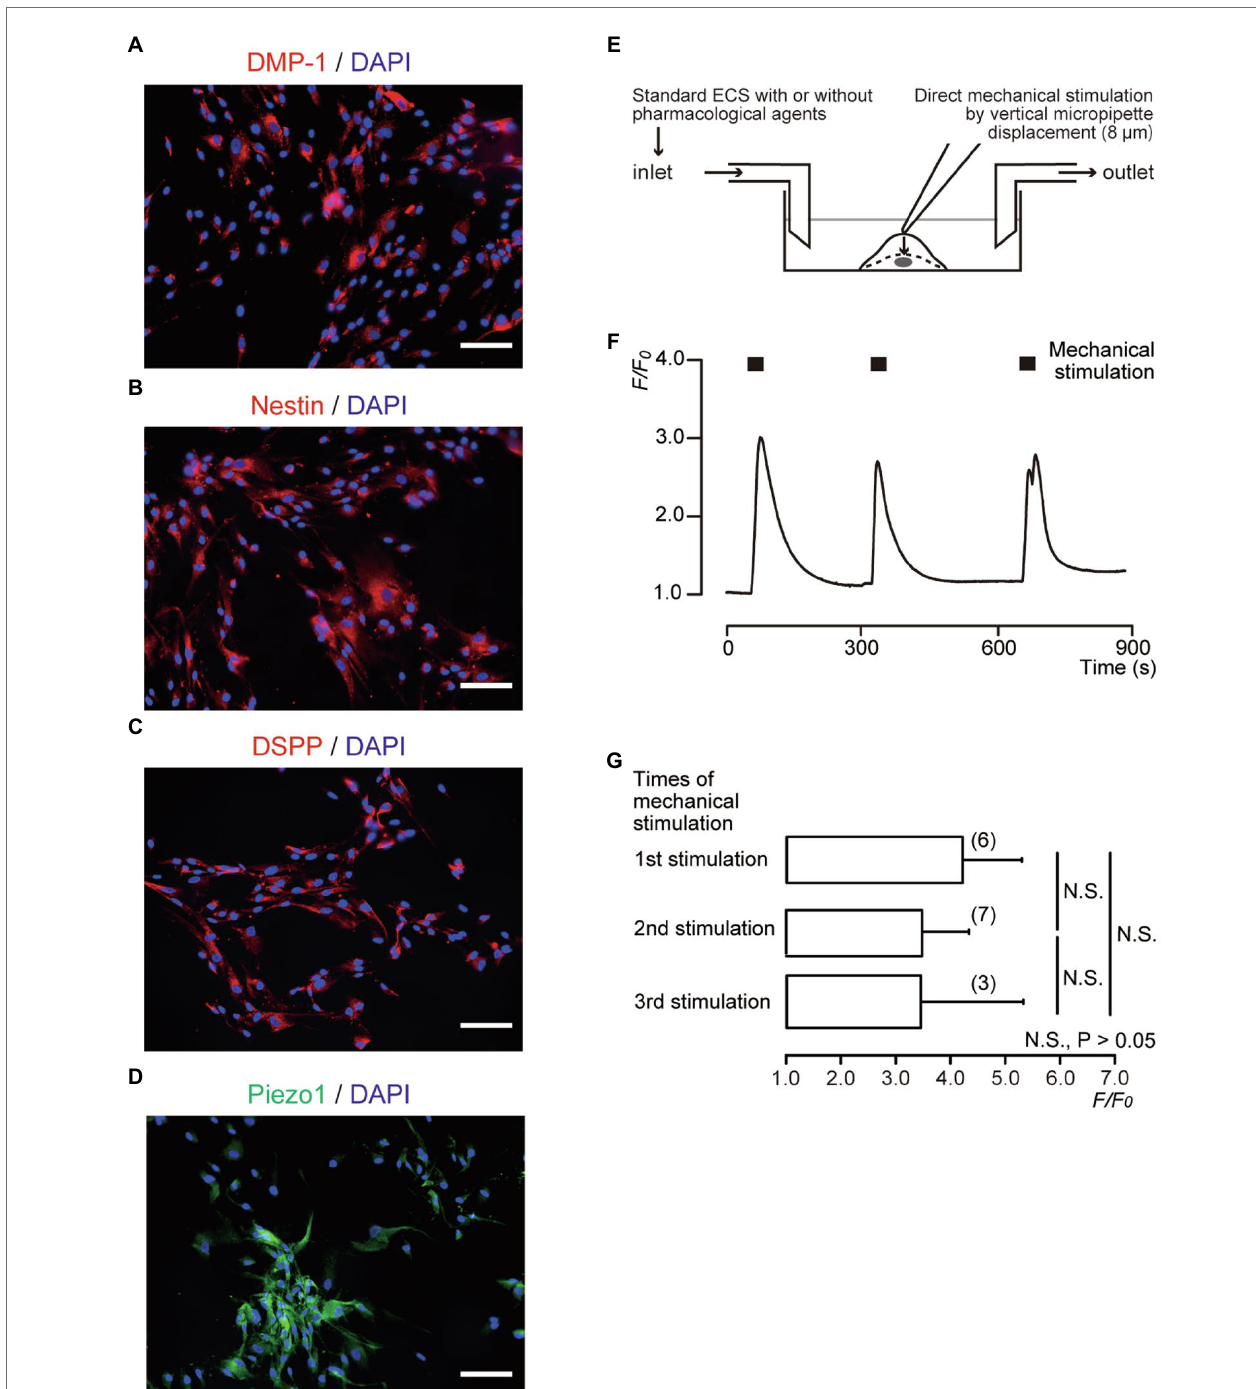
FIGURE 1 | Direct mechanical stimulation transiently increased [Ca 2+ ] i in dentin matrix protein 1 (DMP-1)-, nestin-, and dentin sialophosphoprotein (DSPP)- immunopositive human odontoblasts. (A–D) Human odontoblasts showed positive immunoreactivity to the DMP-1 (red in A ), nestin (red in B ), DSPP (red in C ), and Piezo1 channels (green in D ). Nuclei were represented in blue. Scale bar: 100 μ m. No fluorescence was detected in the negative controls (not shown). (E) Experimental setup for the measurement of Ca 2+ -sensitive dye fluorescence. Standard extracellular solution (standard ECS) with or without pharmacological Piezo1 channel activator/inhibitors was applied from inlet by a rapid gravity-fed perfusion system and aspirated using a vacuum pump. Diagram also shows mechanical stimulation induced by vertical micropipette displacement downward by 8.0 μ m. (F) Representative trace of transient increases in [Ca 2+ ] i during repeated mechanical stimulations (black boxes). (G) Bar graph showing the F / F 0 values as a function of numbers of mechanical stimuli by vertical micropipette displacement (8 μ m). Each bar indicates the mean ± SD. Numbers in parentheses indicate the number of experimented cells. N.S., not